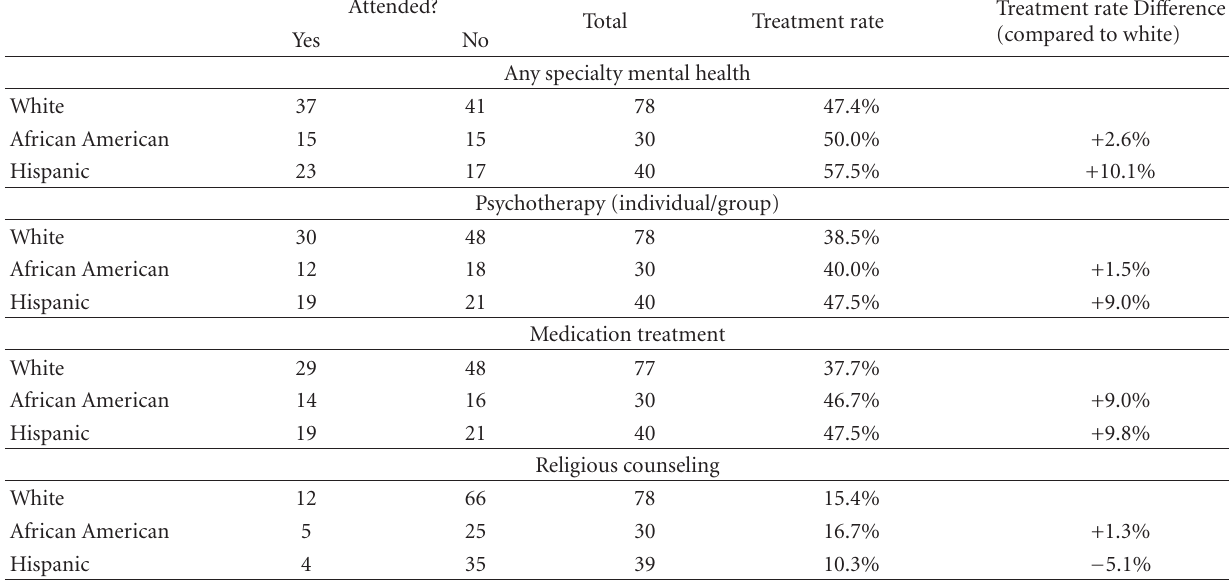
Table 2: Mental health treatment rate di ff erences by racial/ethnic group.